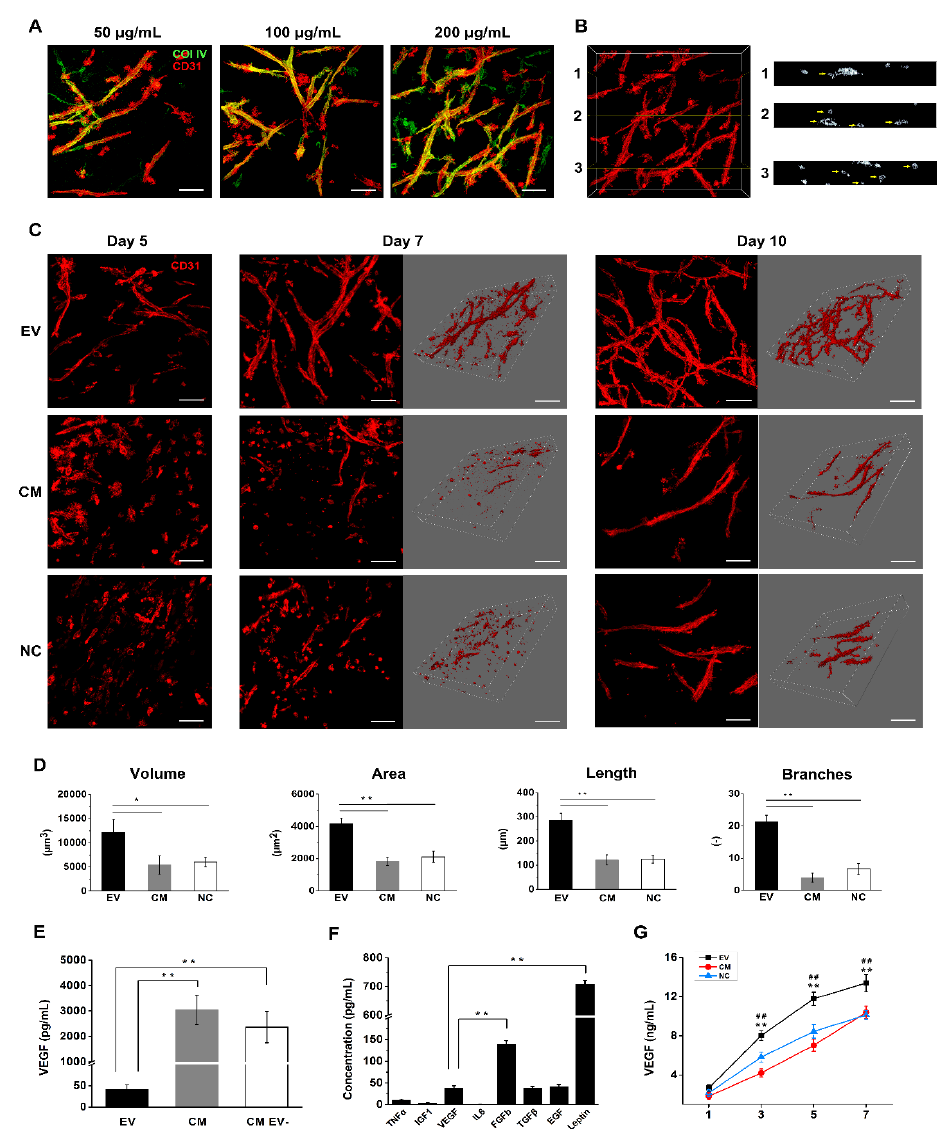
Figure 4. Angiogenesis assays in 3D in vitro culture. ( A ) Images of the EVs dose evaluation in fibrin gel. (Scale bar: 100 µ m) ( B ) Cross-sections of image stacks showing the formation of hollow tubular-like structures in 200 µ g / mL EV-loaded fibrin gel. The lumen structures were pointed by the yellow arrows. ( C ) Images of angiogenesis status in EV-loaded, CM treated, and bare fibrin gel on day 5, day 7, and day 10. (Scale bar: 100 µ m) ( D ) Structure volume, surface area, structure length, and branching points were quantified as parameters. ( E ) VEGF presented in EV lysate, CM, and EV-depleted CM was detected by ELISA. Collected CM was split and EVs were isolated and quantified from one part to allow normalization of the EV concentration (approx. 10 8 EVs / mL). The same depleted medium served as CM EV. ( F ) The angiogenic factors presented in EV lysate were further explored by ELISA. ( G ) The release of VEGF from co-cultures of DPSCs and HUVECs in hydrogels was measured over seven days by ELISA. Cells were cultured in EV-loaded fibrin gel (EV, basal EGF-2) and bare fibrin gels covered with basal EGF-2 (NC) and conditioned medium (CM), (* statistically significant results compared with the CM group, # compared with the NC group). The mean and standard deviation of triplicate experiments are plotted. * p < 0.05, ** / ## p <